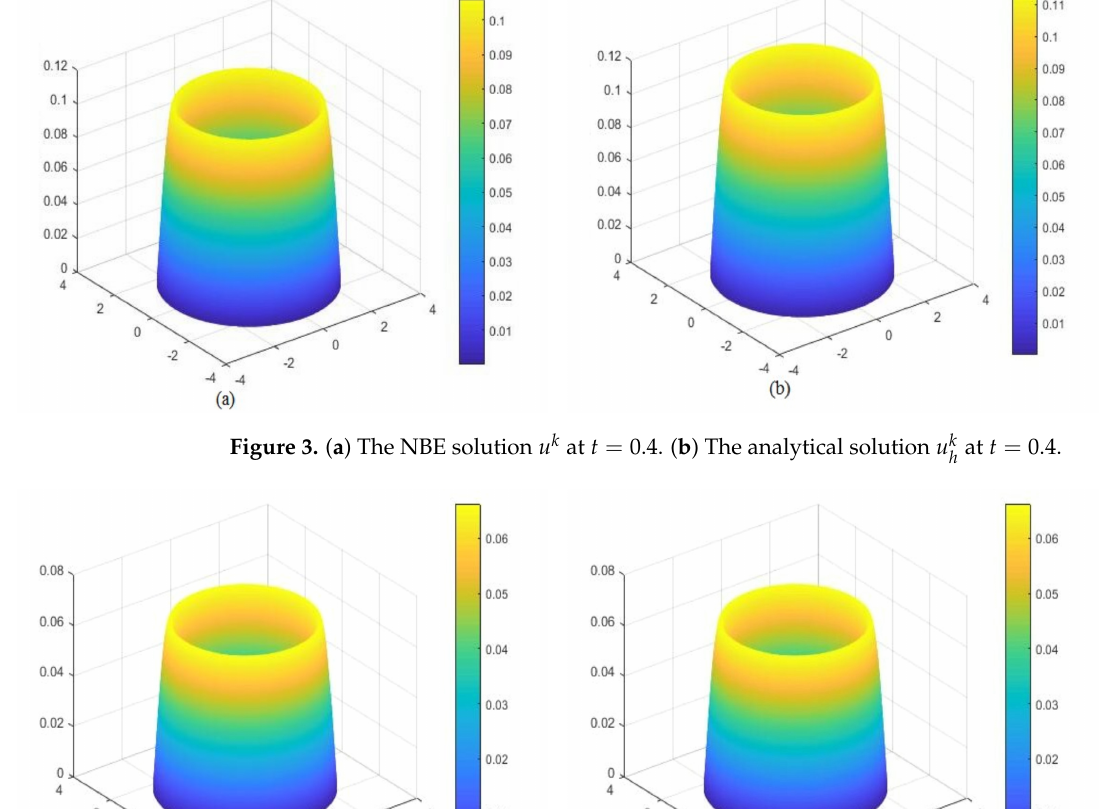
Figure 4. ( a ) The NBE solution u k at t = 0.6. ( b ) The analytical solution u k